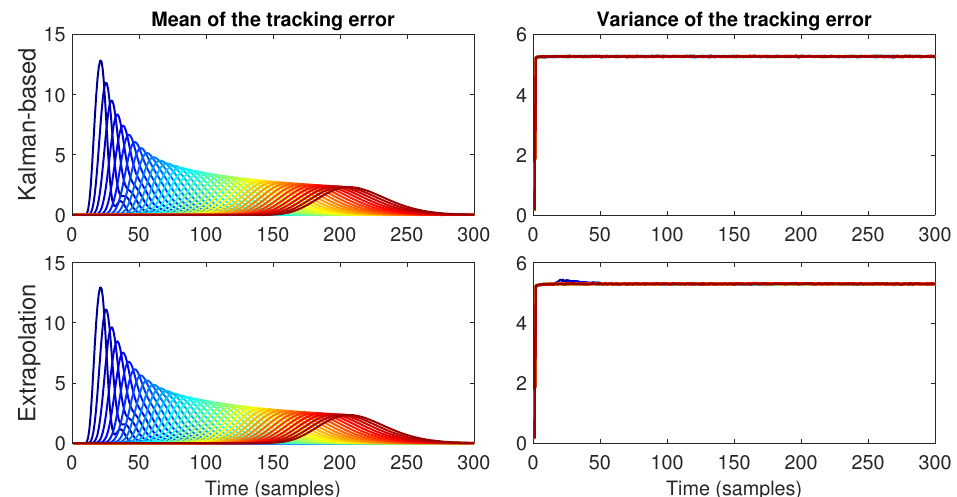
Figure 27. Tracking error with high noise variance for P w and P q . For this scenario, the Monte Carlo simulation converged to a constant value that corresponded with the resulting noise variance of the tracking